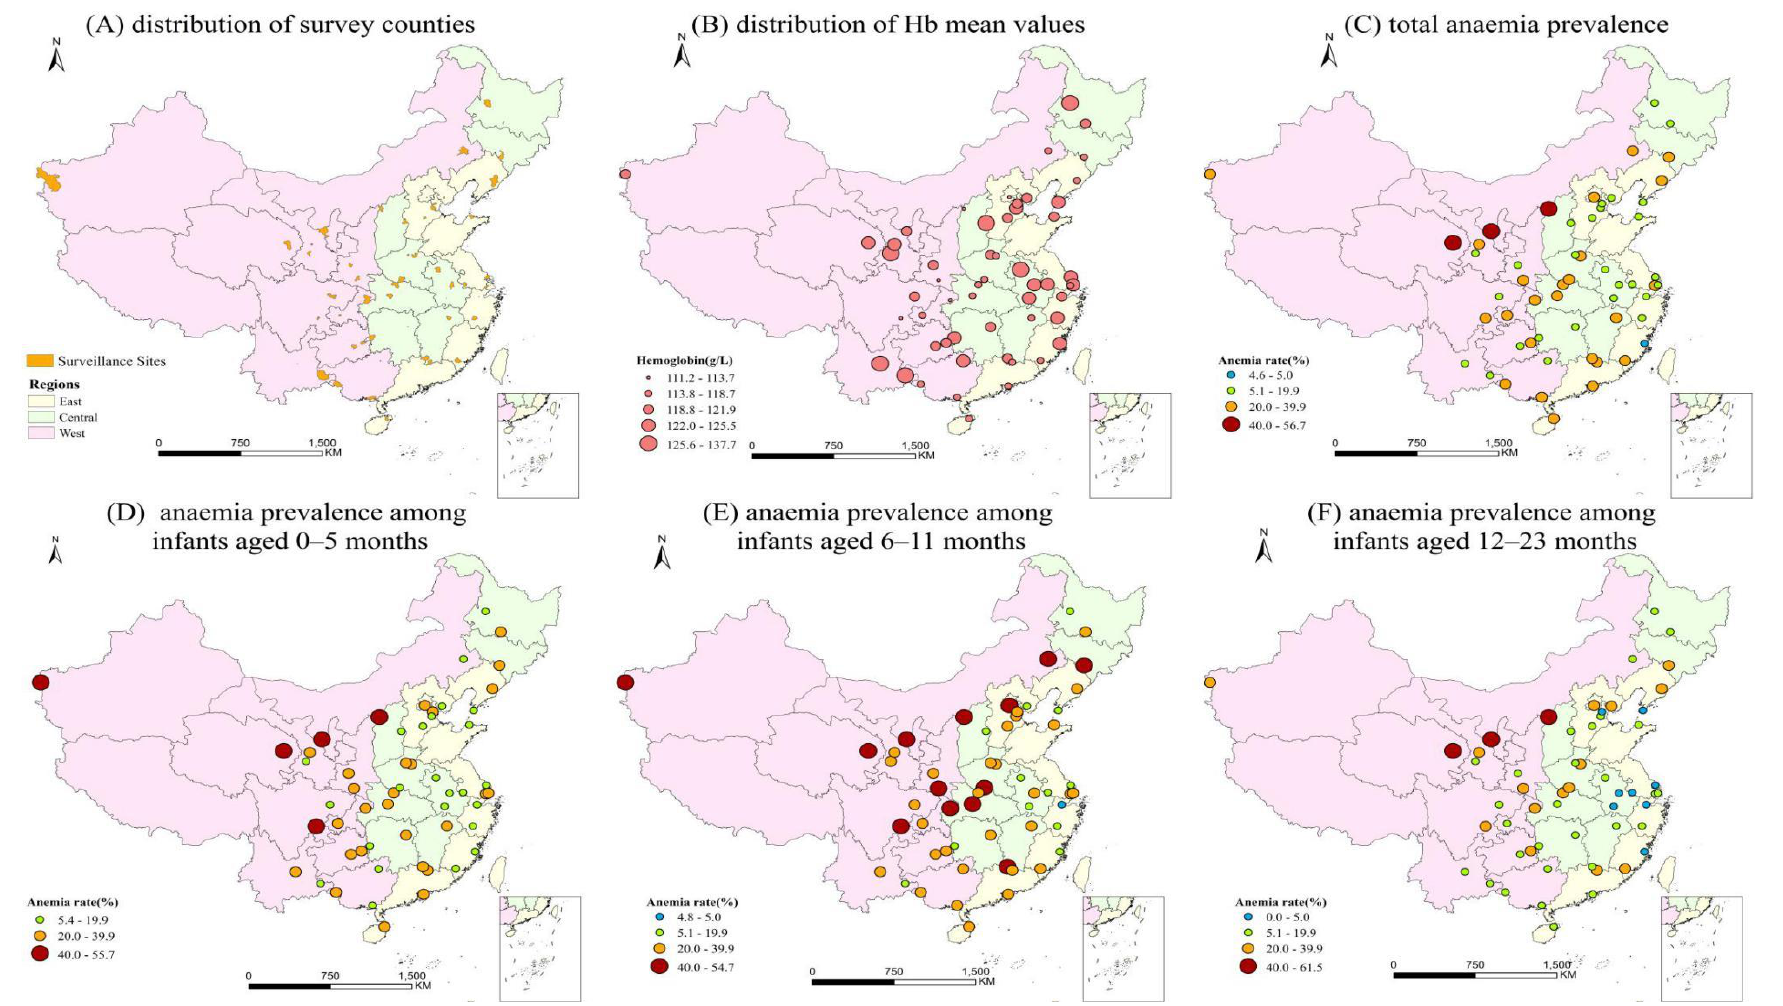
Figure 2. Spatial distribution map of Hb concentrations and anaemia prevalence. ( A ) Distribution of surveillance sites, ( B ) distribution of Hb mean values, ( C ) total anaemia prevalence, ( D ) anaemia prevalence among infants aged 0 – 5 months, ( E ) anaemia prevalence among infants aged 6 – 11 months and ( F ) anaemia prevalence among infants aged 12 – 23 months.